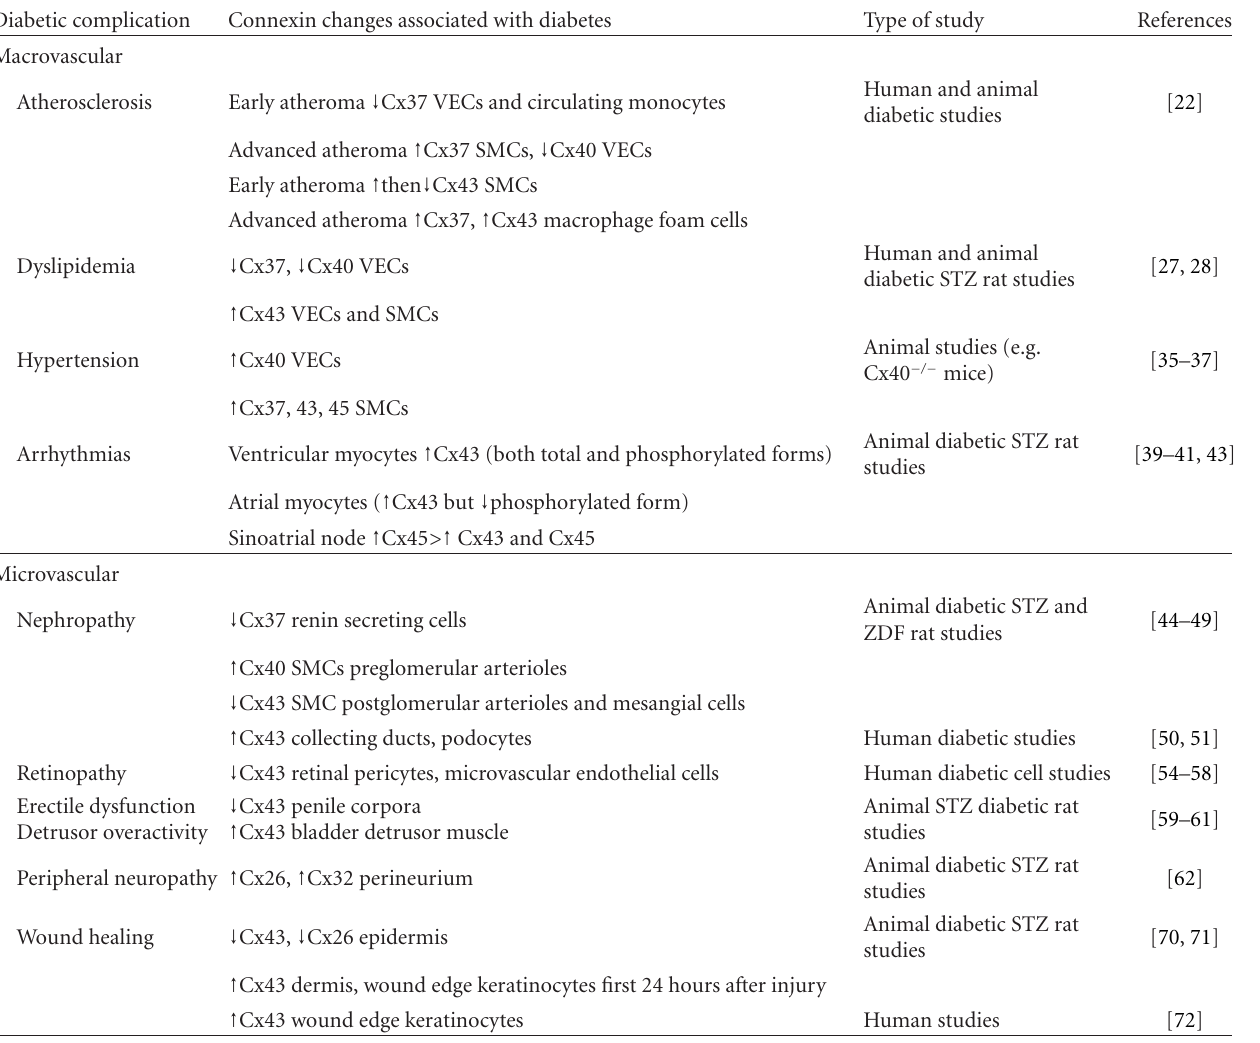
Table 1: Connexin changes associated with diabetic complications (upward and downward arrows indicate increase or decrease in Cx levels, VECs: vascular endothelial cells, SMCs: smooth muscle